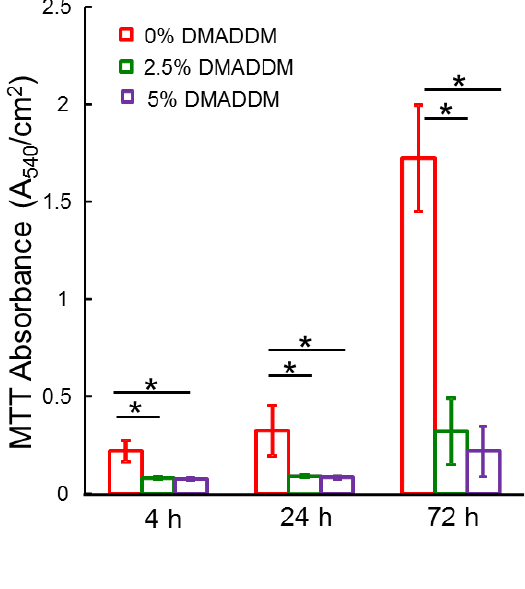
Figure 2. MTT metabolic activity in three groups. Biofilms were grown for 4, 24 and 72 h days using an S. mutans model. Each values is mean ± SD ( n = 6) ( * p < 0.05).